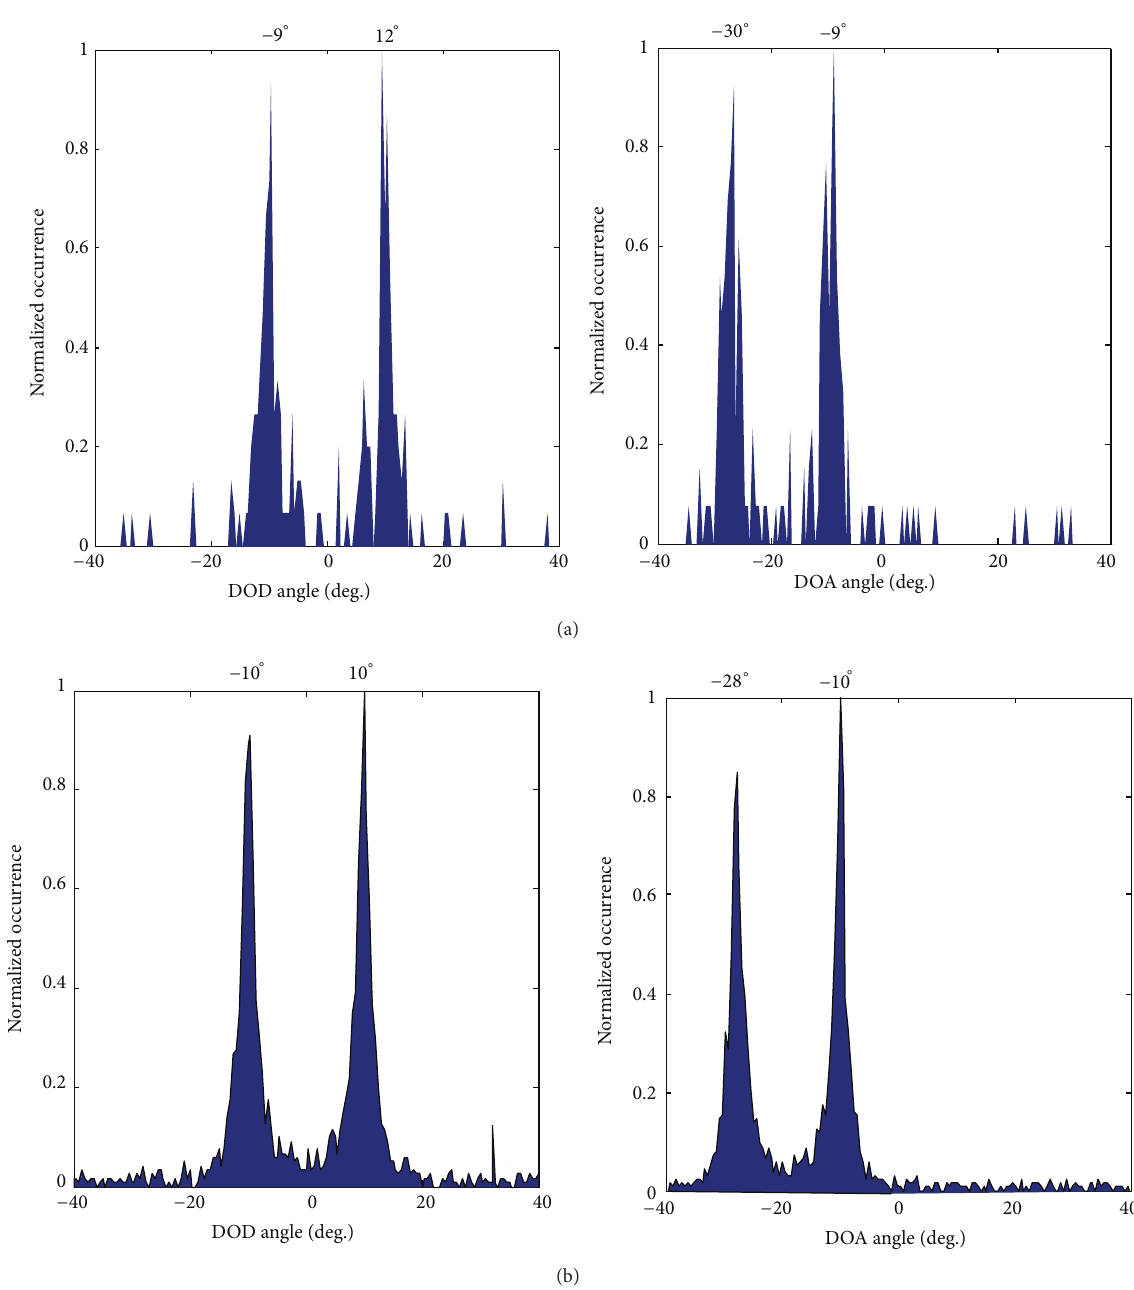
Figure 12: Angle histograms of estimated DODs and DOAs in detecting Weibull targets using a signal bandwidth of (a) 50 and (b) 1000 MHz.